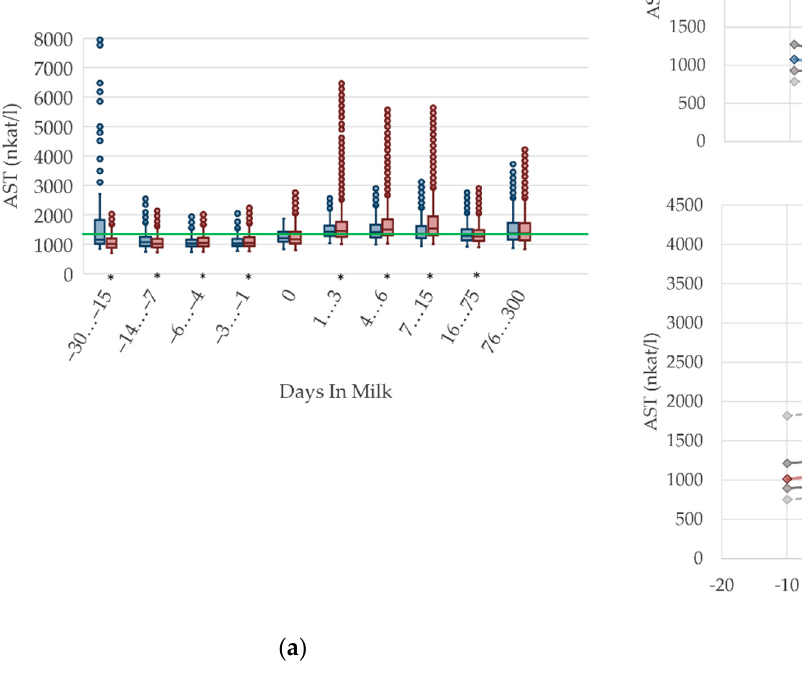
Figure 6. Serum activities of aspartate aminotransferase (AST) in primiparous (blue) and in multiparous (red) cows ( a ) in 10 classes between 30 days prepartum to 300 days postpartum (boxplots), green continuous lines represent the reference values according to Fürll [23],